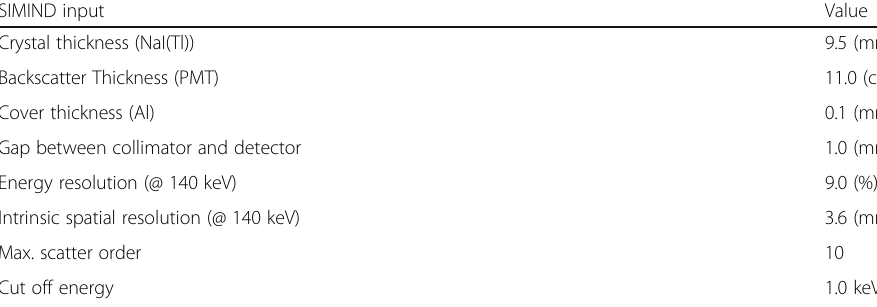
Table 2 SIMIND input parameters for simulation of a Siemens Symbia Gamma Camera Detector SIMIND input Crystal thickness